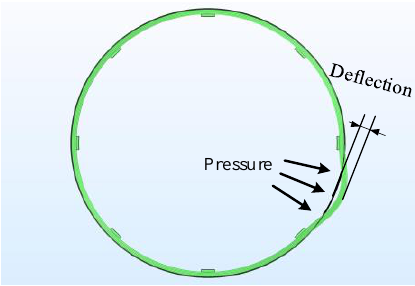
Figure 11. Schematic diagram of winding deformation.